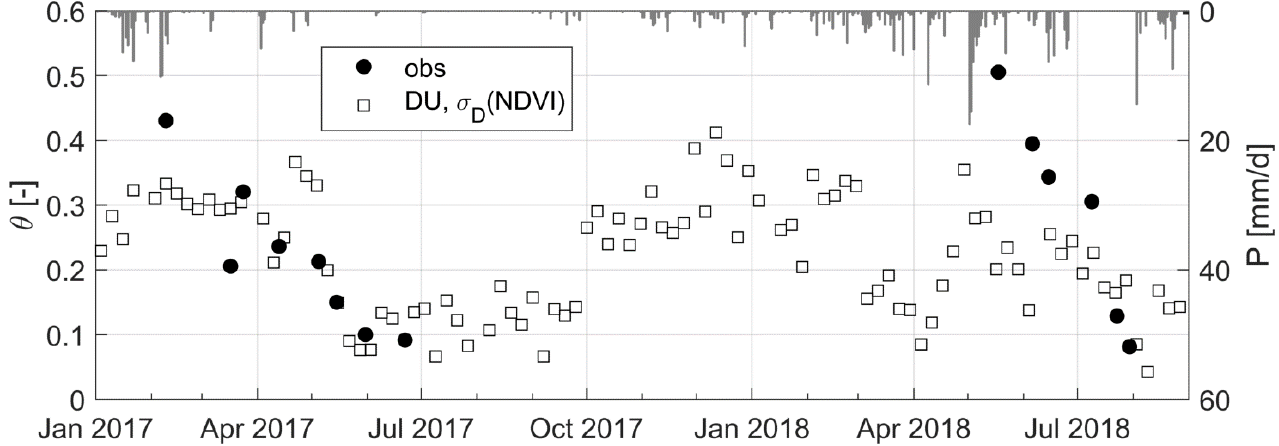
Figure 7. At the second grass field site, the comparison between observed soil moisture (obs), and estimated soil moisture from Sentinel 1 using the DU method and the proposed σ D (NDVI) relationship (DU, σ D (NDVI)).